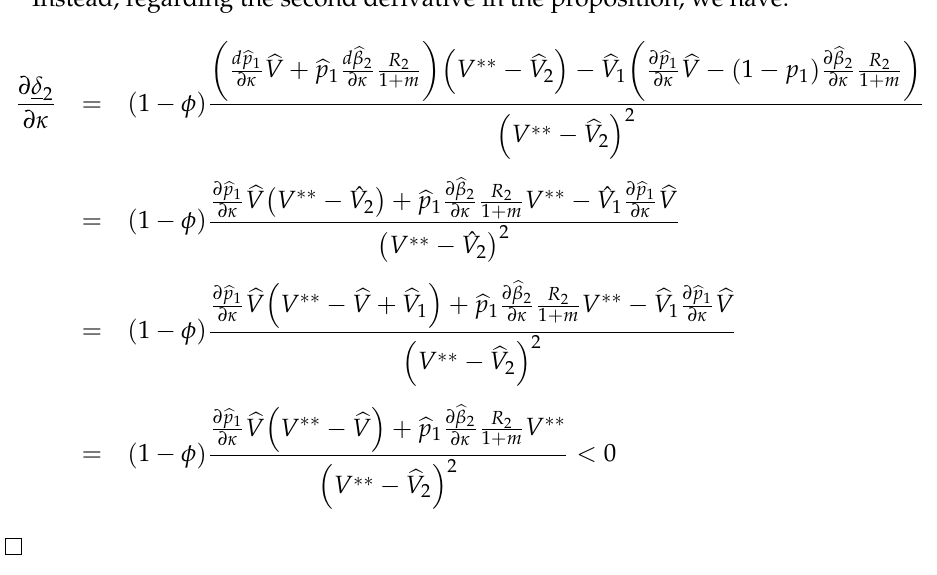
Table A1. Values for the sensitivity analysis.